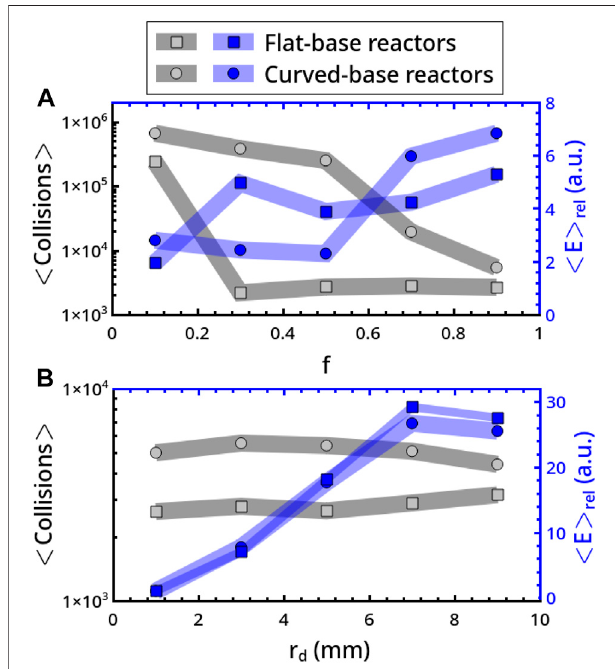
FIGURE 6 | Analysis of the average number of collisions on the reactor bases, 〈 Collisions 〉 (in gray-black), and relative energy per collision, 〈 E 〉 rel (in blue). 〈 E 〉 rel wasevaluatedinrelationtoadiscofradiusrd=5mm,towhichwe attributed unitary mass. 〈 Collisions 〉 and 〈 E 〉 rel are characterized as a function of f ( r d = 3 mm) in panel A and r d ( f = 0.9) in panel B. Squares and circles refer to fl at- and curved-base reactors,